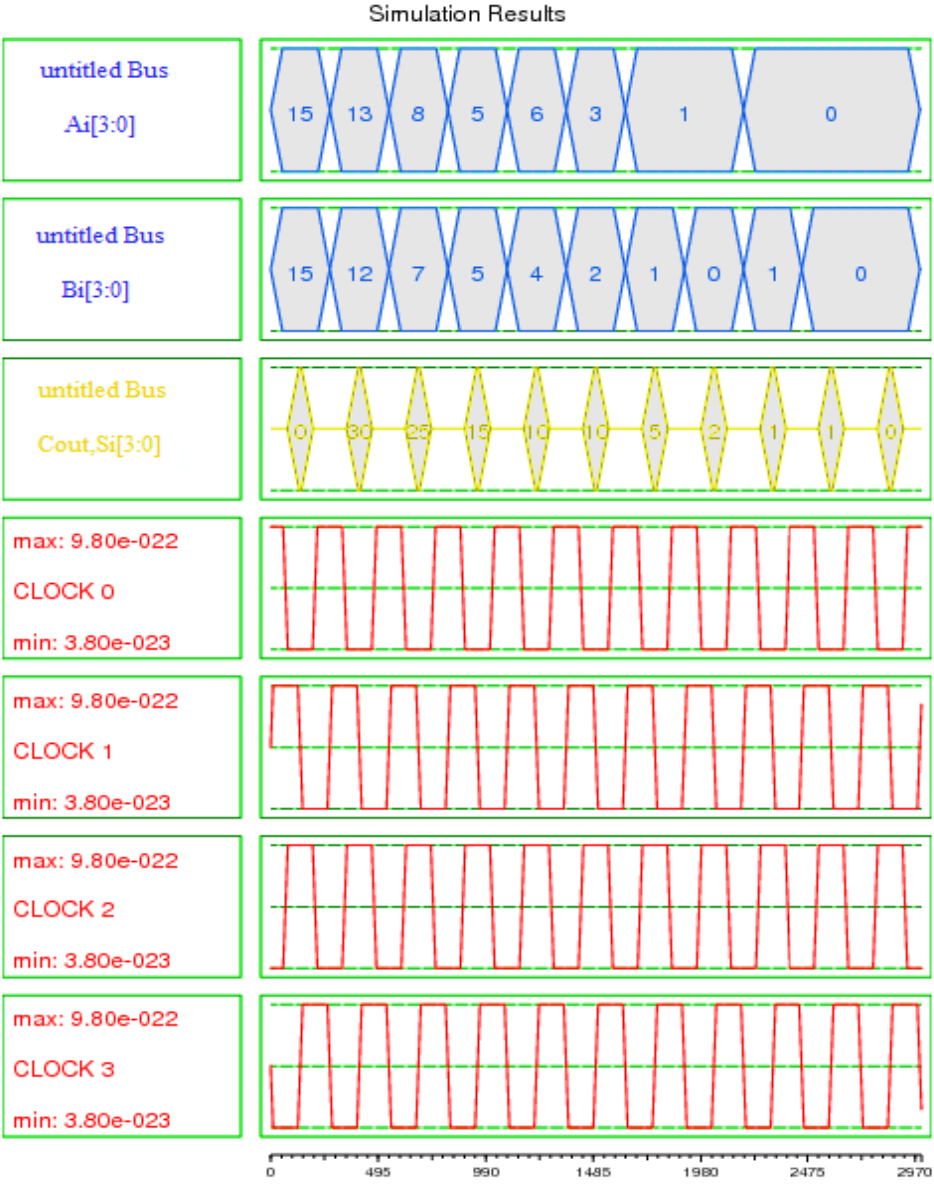
Figure 9. Simulation results for the proposed ( A , B ) 4-bit RCA circuits.